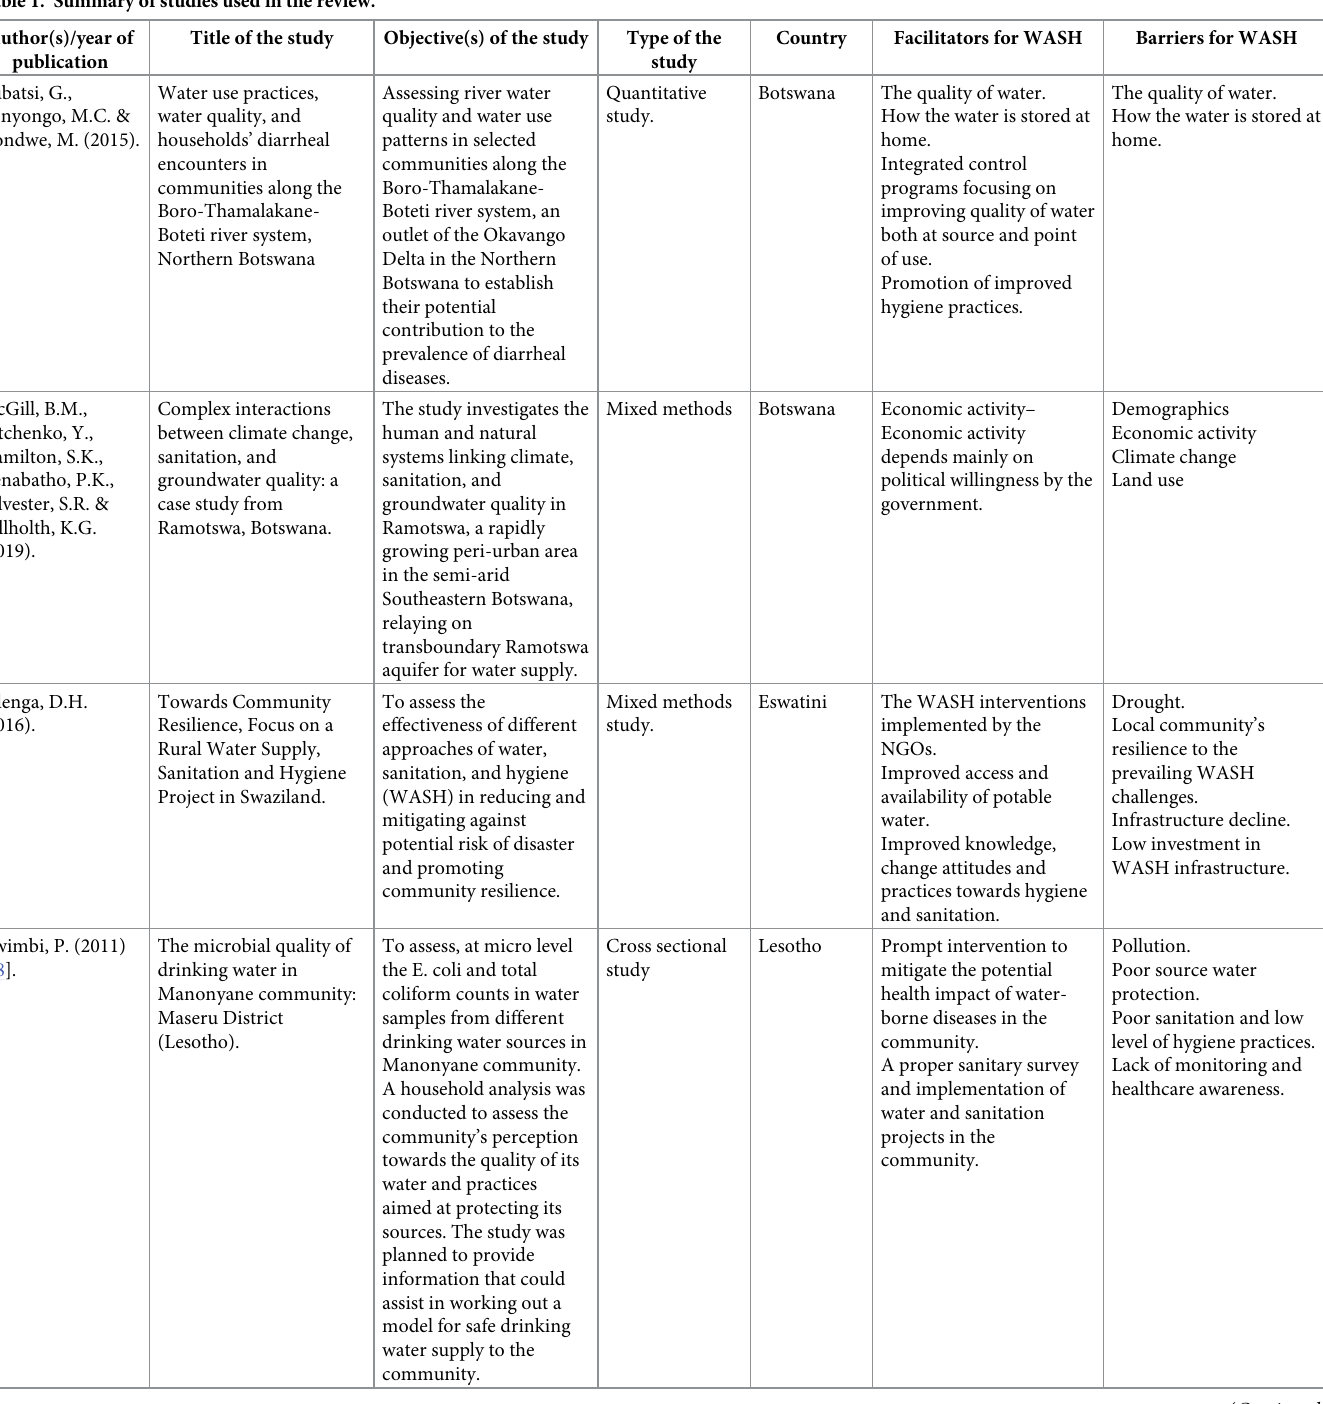
Table 1. Summary of studies used in the